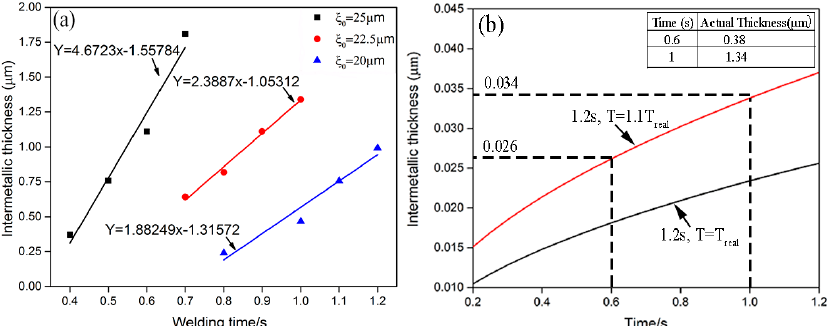
Figure 5. ( a ) Changes in the intermetallic thickness with welding time at various amplitude levels; ( b ) Predicted thickness of the intermetallic layer for 1 s of weld, with and without considering thermal measurement errors ( Q = 72.013 kJ · mol − 1 [23]).